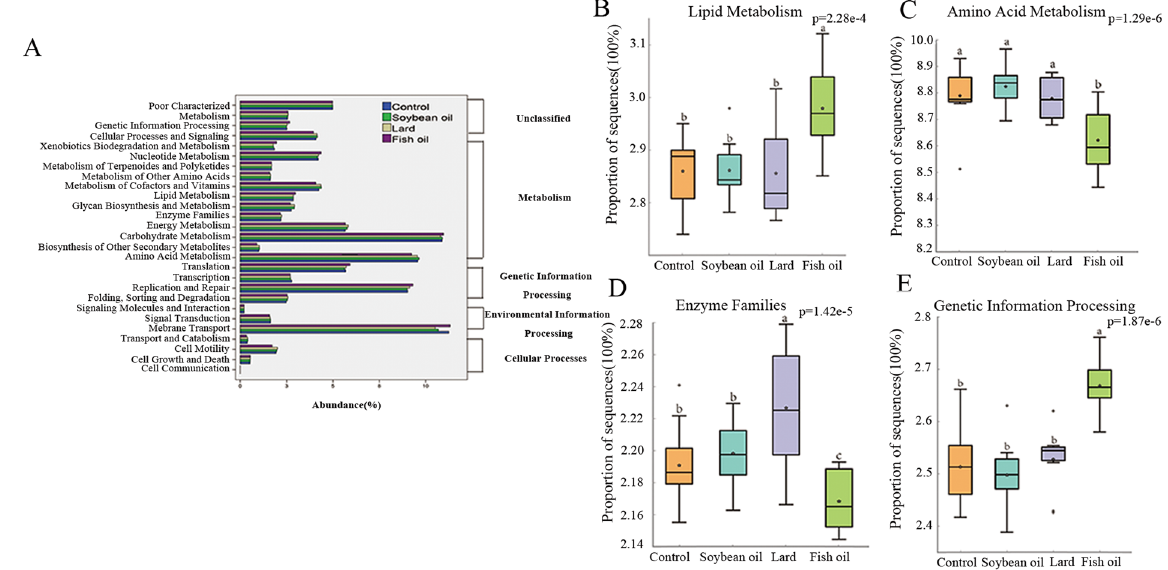
Figure 6. PICRUSt recapitulates biological findings. ( A ) Abundances of KEGG pathways in level-2 functional prediction by PICRUSt. ( B ) Lipid metabolism. ( C ) Amino acid metabolism. ( D ) Enzyme families. ( E ) Genetic information processing. The data were analyzed by one-way analysis of variance and means were compared by the procedure of Duncan’s multiple-range comparison. a,b,c means with different letters differed significantly (p < 0.05).